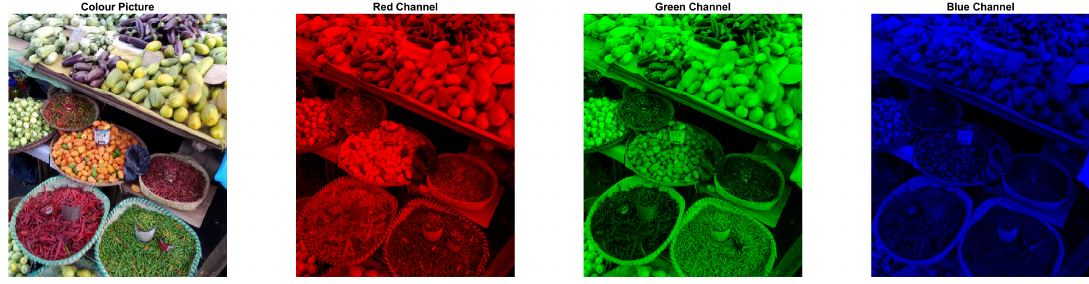
Figure A1. Separation of red, green and blue channels of a color picture. Image courtesy of Diego Rattazzi